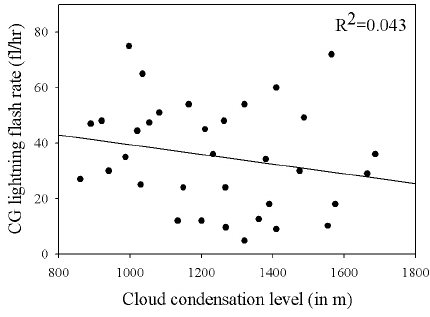
Figure 2. Scatterplot of the CG lightning flash rate and convective condensation level over Taipei during premonsoon